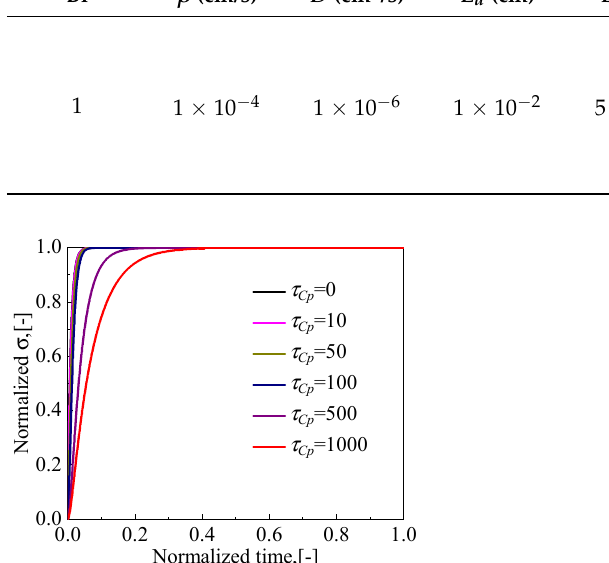
Figure 7. Conductivity relaxation curves of different τ Cp .